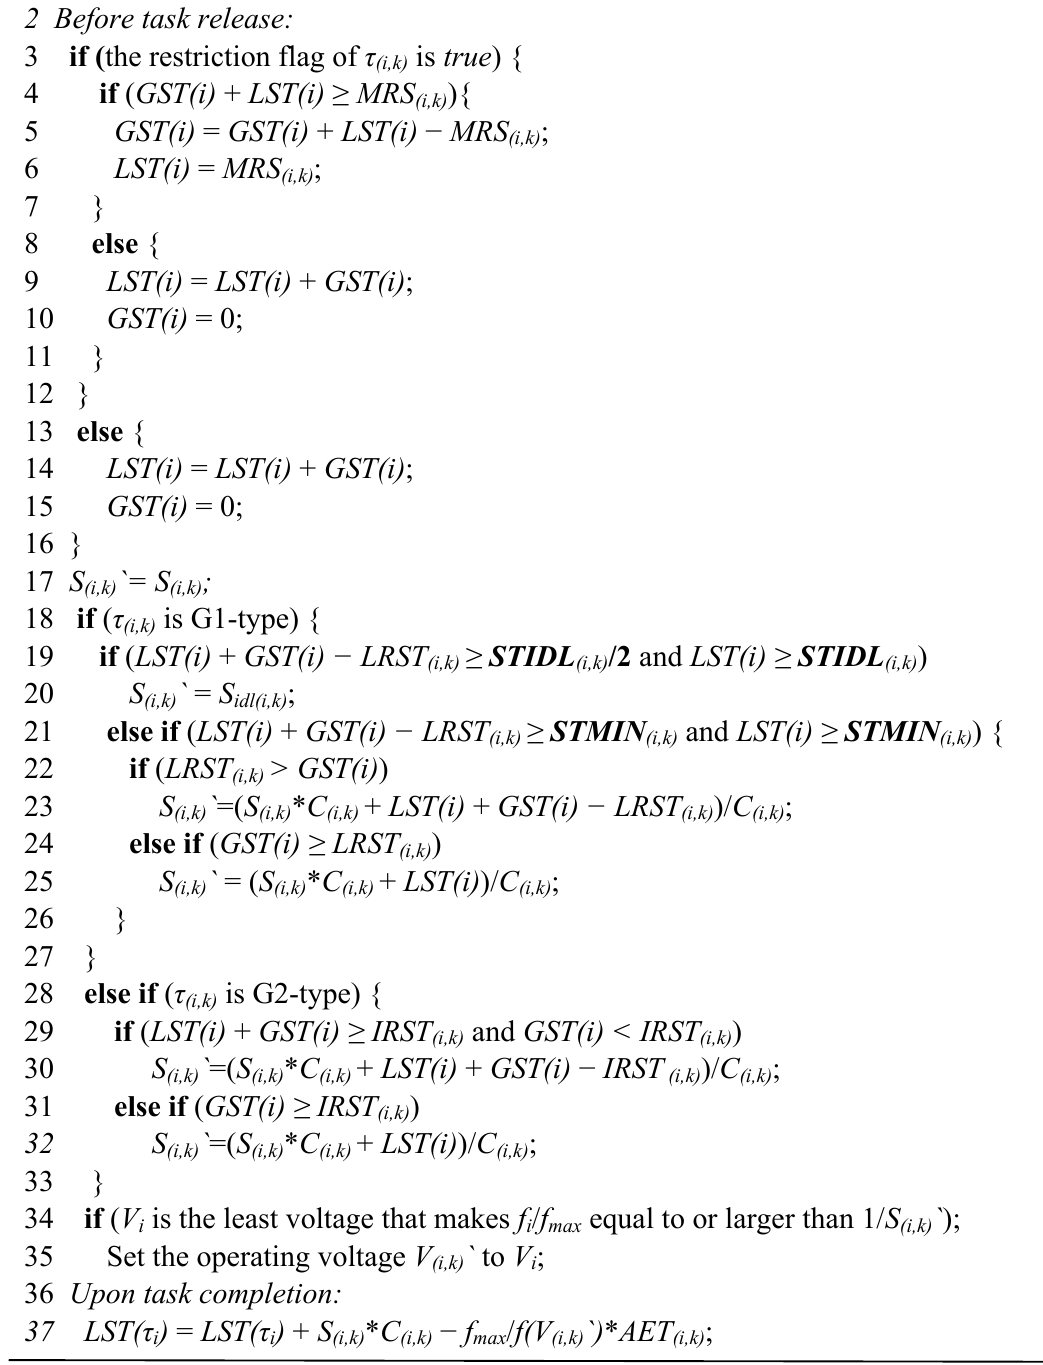
Algorithm 2. HTDVS-SRT algorithm.